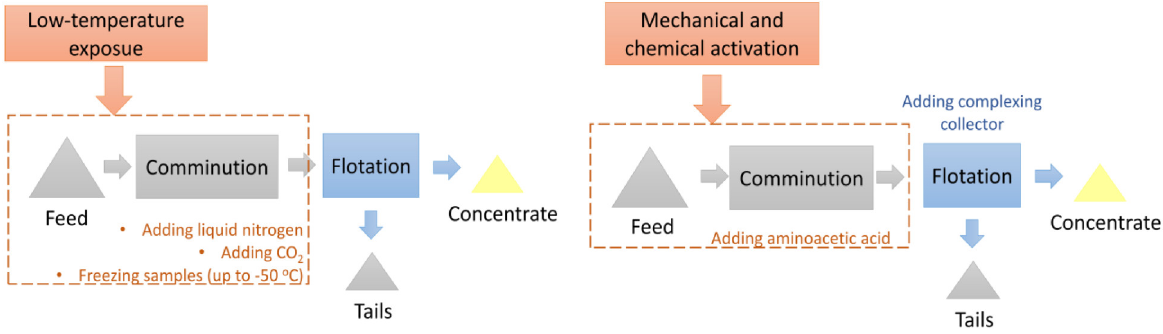
Figure 5. The scheme of the investigations into the application of low-temperature exposure ( left )